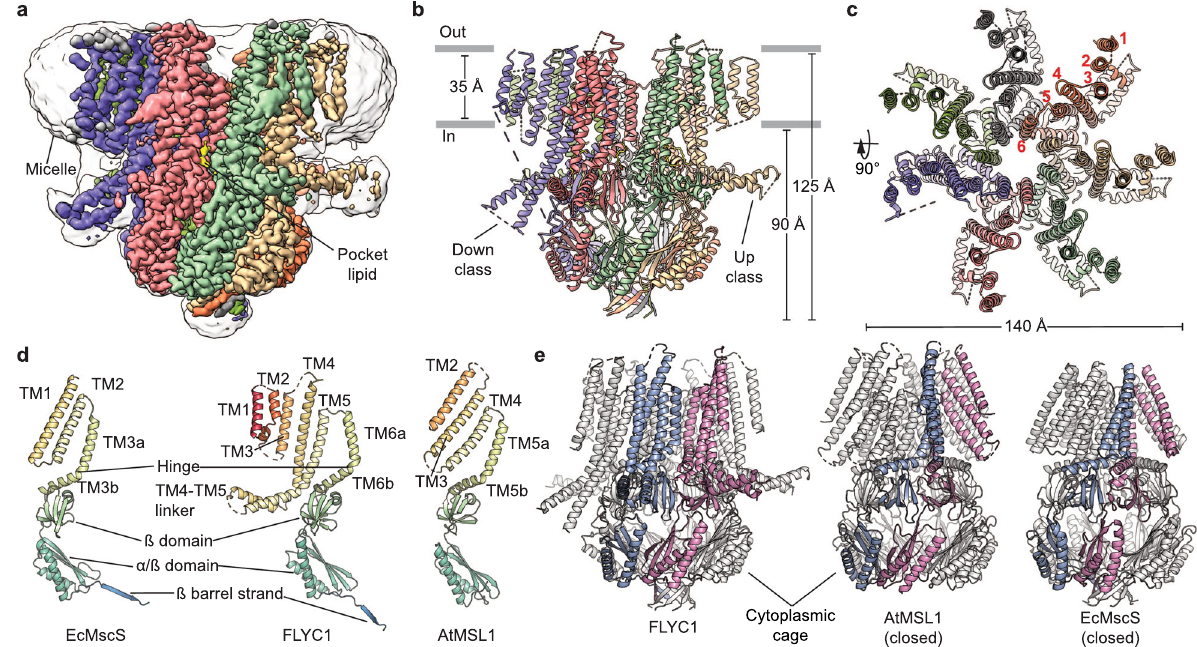
Fig. 1 FLYC1 structure. a Cryo-EM density of FLYC1 colored by subunit and enclosed in detergent micelle (unsharpened map gaussian- fi ltered to 1.5 σ ). Side ( b ) and top ( c ) view of FLYC1 model. In top view, TM helices are labeled from 1 to 6, according to their position in the amino acid sequence. d Cartoon representation of protomers of EcMscS (PDB: 2OAU, closed state), FLYC1, and AtMSL1 (PDB: 6VXM, closed state). e Side views of FLYC1 heptamer and its homologs, with two protomers colored blue and pink, respectively. Rotation of TM helices of each protomer relative to conserved cytoplasmic cage is limited for FLYC1 relative to AtMSL1 and EcMscS, where TM helices interact with cytoplasmic domain of the contiguous subunit. TM1 – TM2 of FLYC1 are not shown for